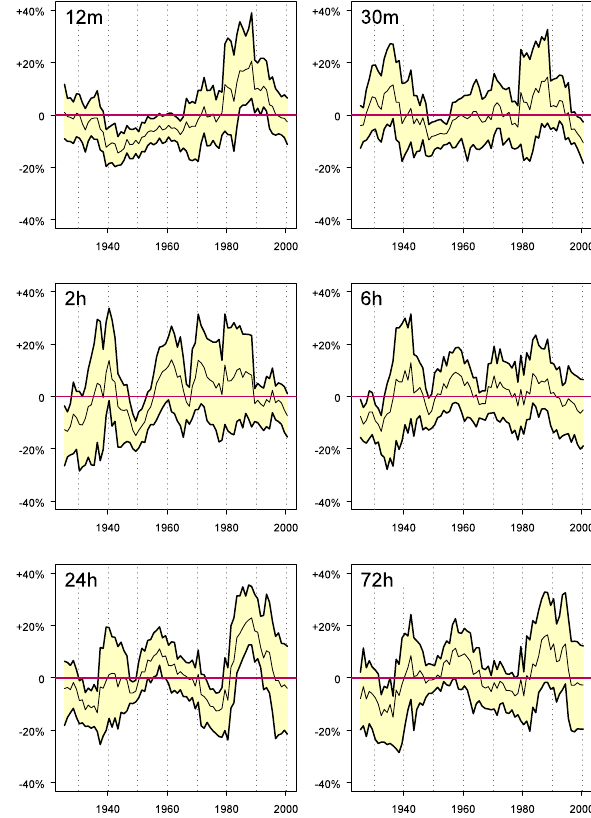
Fig. 2. 90% confidence intervals for the percentage differences be- tween frequency for 10-yr sliding windows and the long-term aver- age for POT3. For clarity only 6 durations are shown.